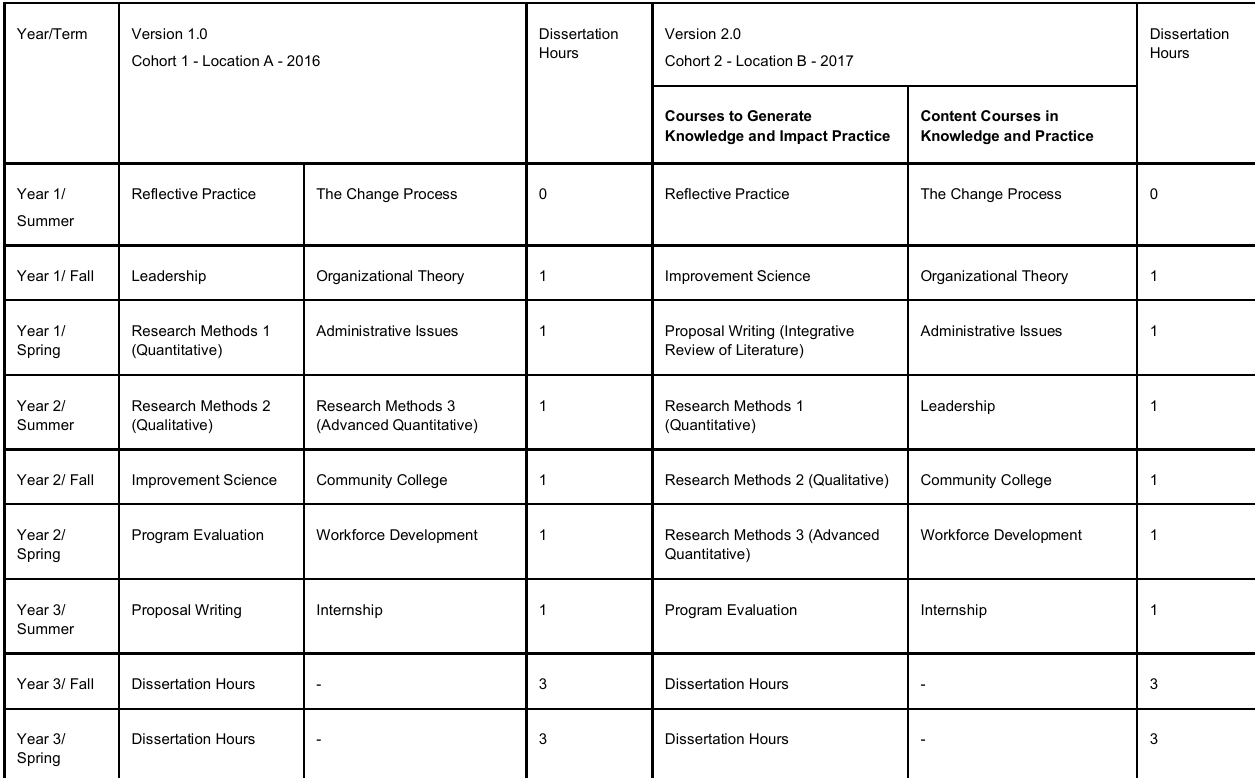
Table 1. Courses and Sequence for EdD Community College Cohort Year/Term Version 1.0 Cohort 1 - Location A -